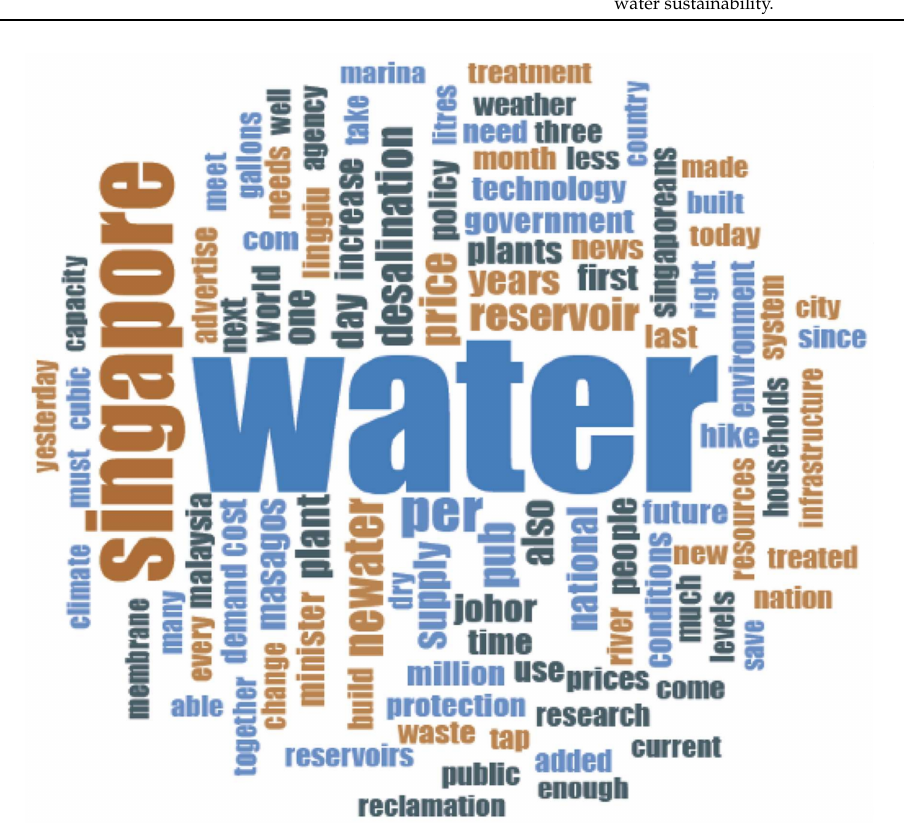
Figure 1. The Straits Times : terms associated with potable water